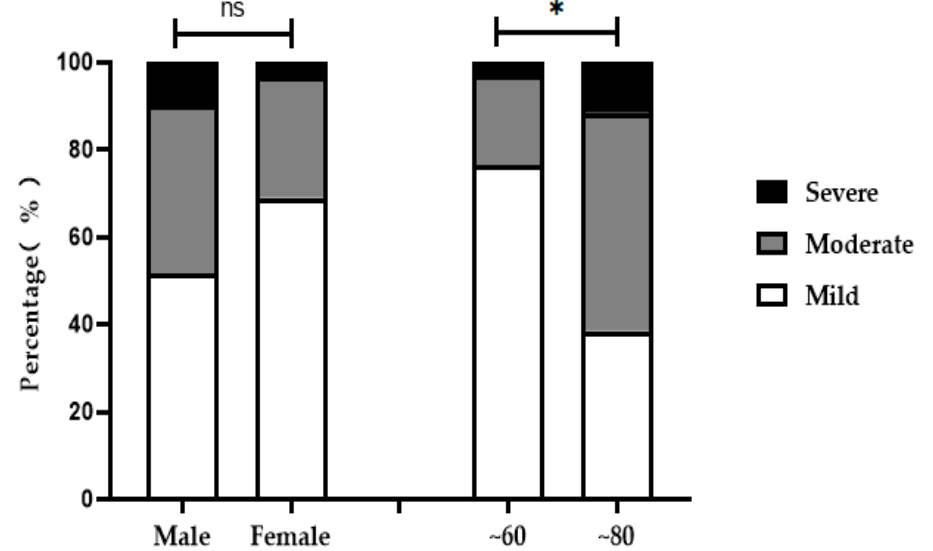
Figure 3. X-ray grade analysis of SF patients of different age groups and sexes. The SF group included 31 males and 29 females and was divided into ~60 ( n = 34)- and ~80 ( n = 26)-years-old groups. ns p > 0.05 compared to males; * p < 0.05 compared to the ~80-year-old group.